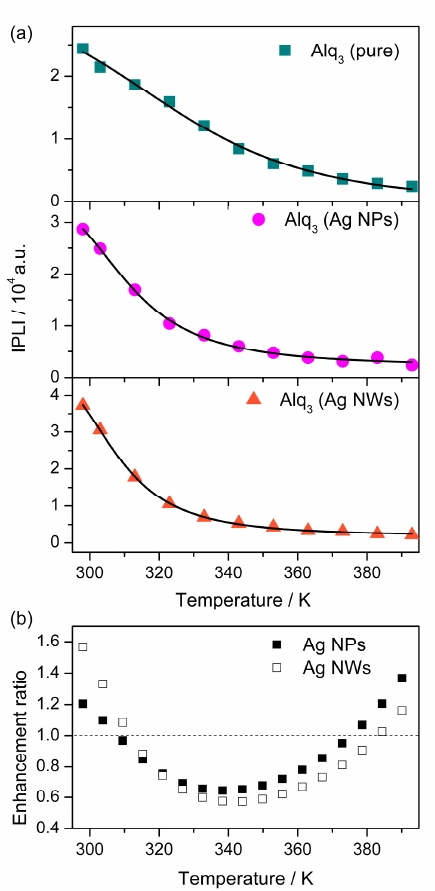
Figure 6. ( a ) Temperature-dependent IPLI of Alq 3 (pure), Alq 3 (Ag NPs) and Alq 3 (Ag NWs); ( b ) IPLI enhancement ratio as a function of temperature.